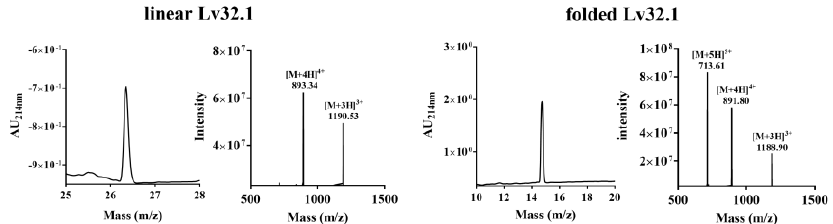
Figure 1. HPLC and LC-MS spectra of linear and folded Lv32.1.